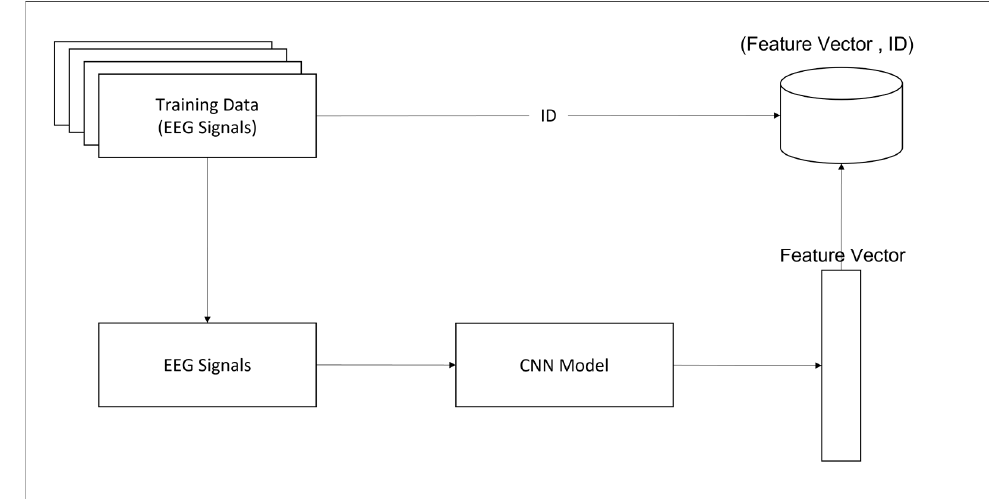
Figure 1. Enrollment Phase.